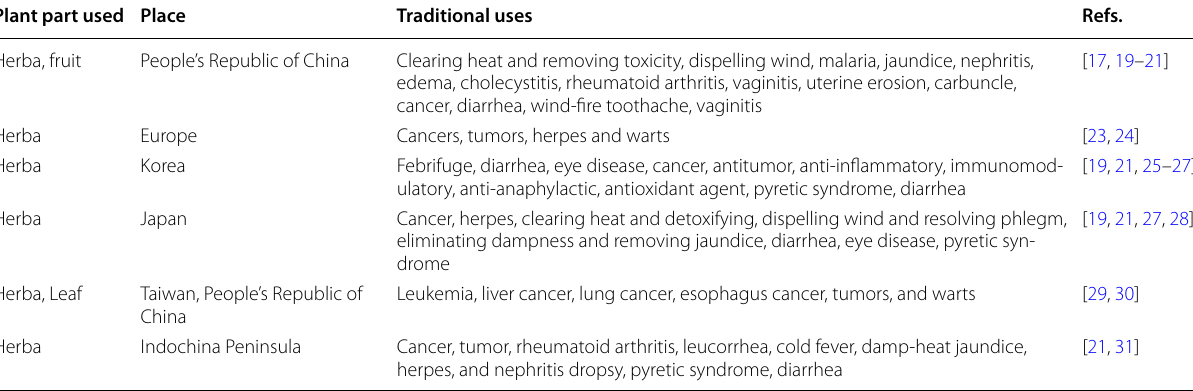
Table 1 Traditional uses of S. lyratum Plant part used Place